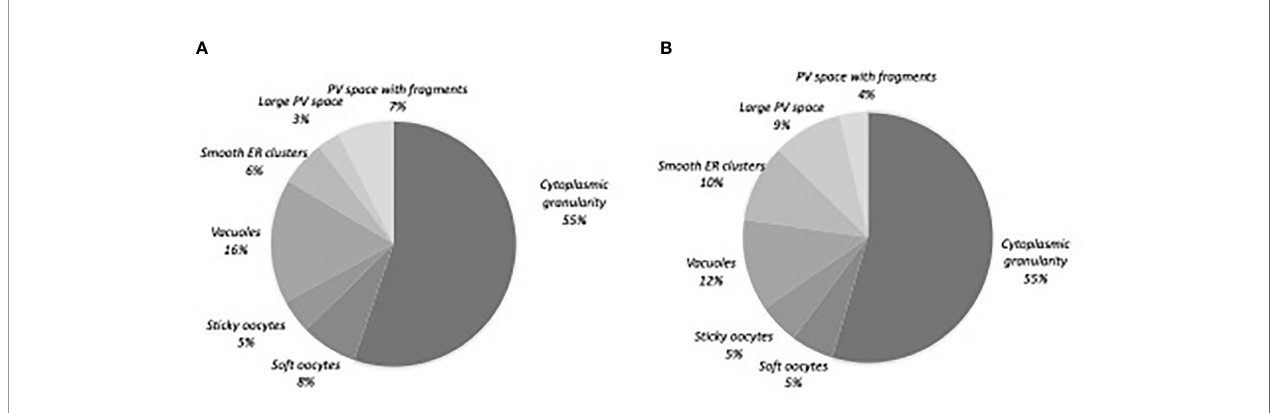
FIGURE 2 | Distribution of the oocyte morphological abnormalities. (A) Normal oocyte cohort, n=61 oocytes (B) Abnormal oocyte cohort, n=246 oocytes. PV, perivitelline; ER,